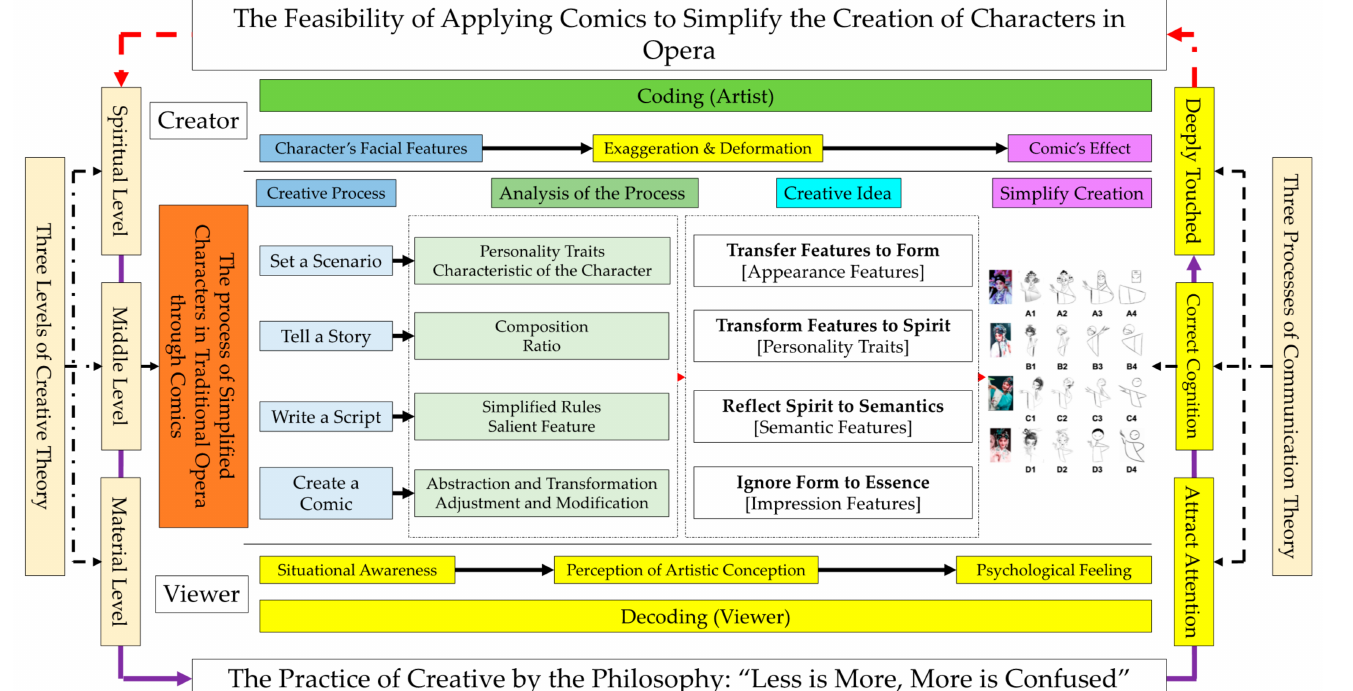
Figure 9. The framework of future research (Source: this